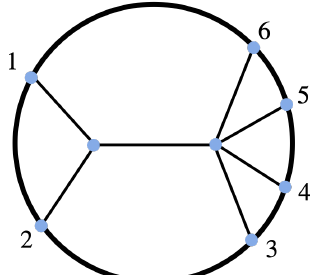
) by taking a double coincidence limit ◦◦◦◦◦◦